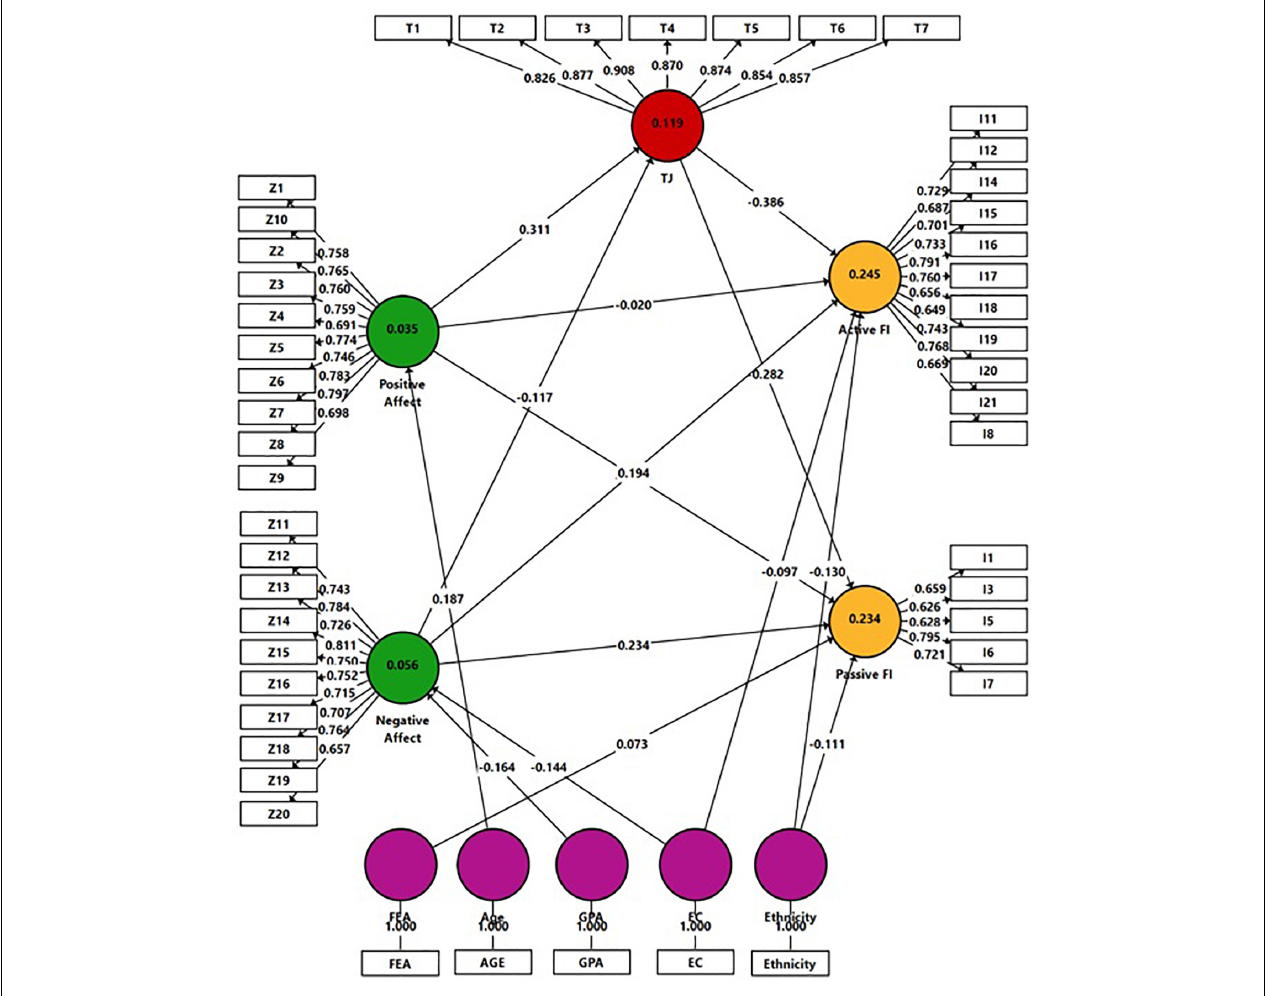
FIGURE 2 | Model 2: Analysis results of the examination of H3–H5 by